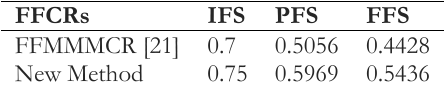
Table 2. Results of composite